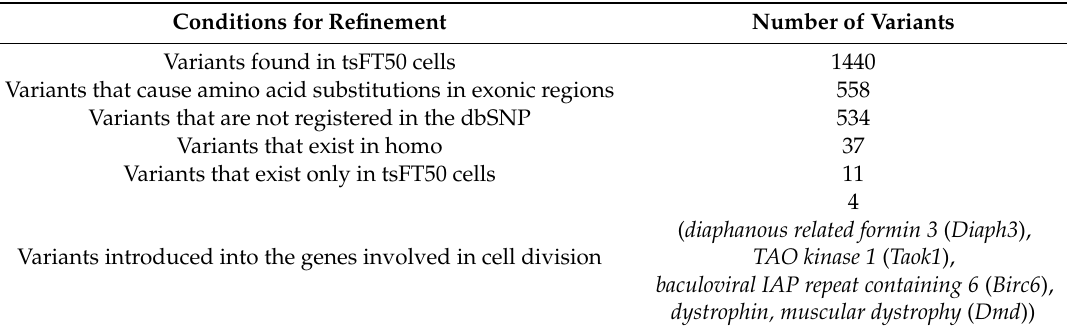
Table 2. Exome analysis of tsFT50